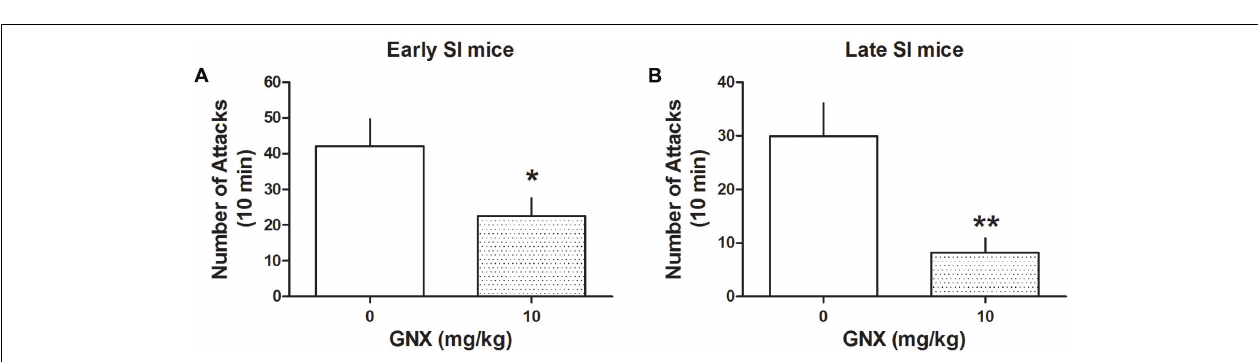
FIGURE 3 | The analog of Allo, ganaxolone (GNX) ameliorates aggressive behavior in early and late adolescent SI mice. GNX (10 mg/kg, EC 50 dose) was administered both to early (A) and late (B) adolescent SI mice 60 min before the exposure to a resident–intruder test. Equal doses of GNX showed a more powerful improvement in social isolation-induced aggression of late adolescent SI mice. Data represent the mean ± SEM of 12–13 mice. ∗ p < 0.05; ∗∗ p < 0.01, when compared with basal control levels of aggression.